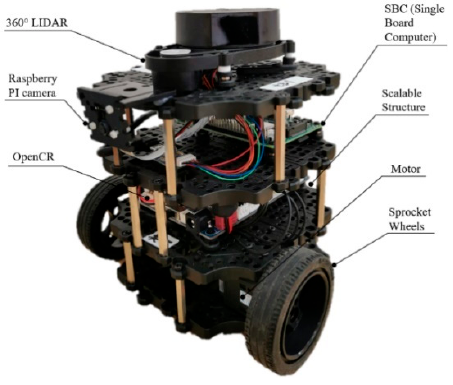
Figure 13. The TurtleBot3 Burger. Table 1. The configuration table of burger.